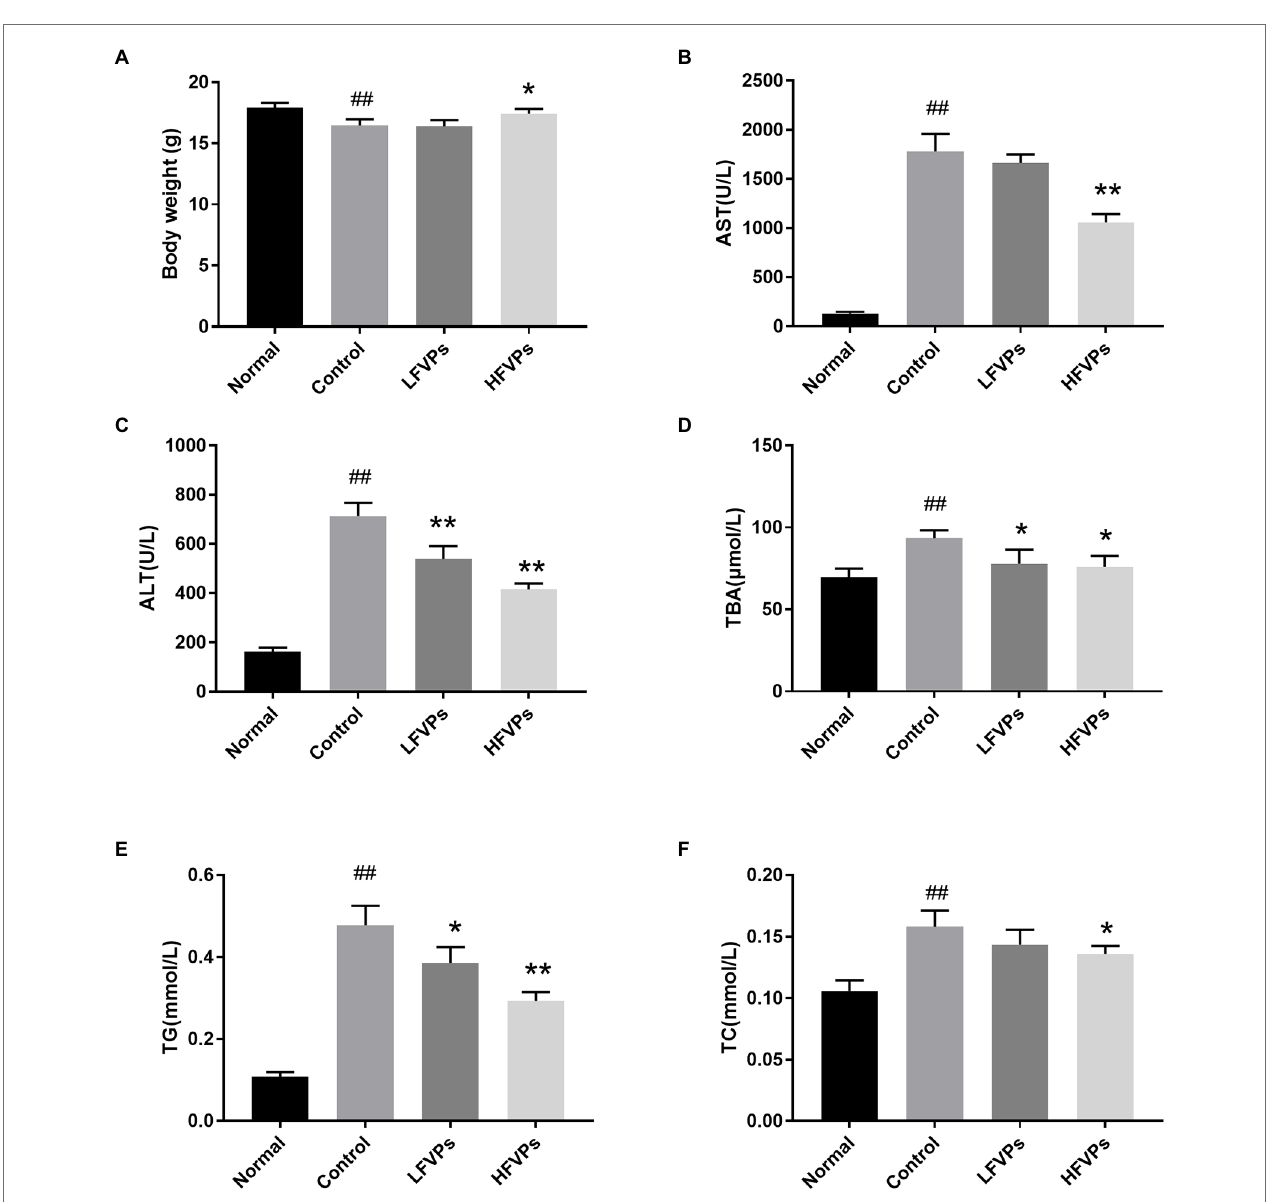
FIGURE 2 | Effect of treatment with FVPs on (A) body weight and content of certain biochemicals in the serum: (B) aspartate transaminase (AST), (C) alanine aminotransferase (ALT), (D) total bile acid (TBA), (E) triglyceride (TG), and (F) total cholesterol (TC). The data are presented in the form: mean ± SD (with eight mice per group). The symbols # and ## represent significance levels of p < 0.05 and p < 0.01 compared to the Normal group, respectively. Similarly, * and ** represent p < 0.05 and p < 0.01 compared to the Control group,